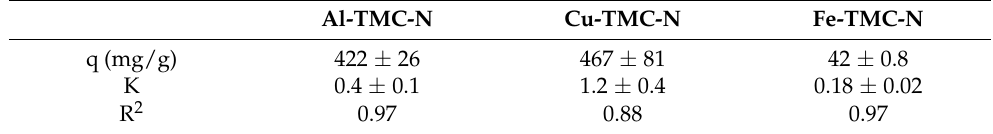
Table 1. Langmuir isotherm parameters for the TMC materials at 295